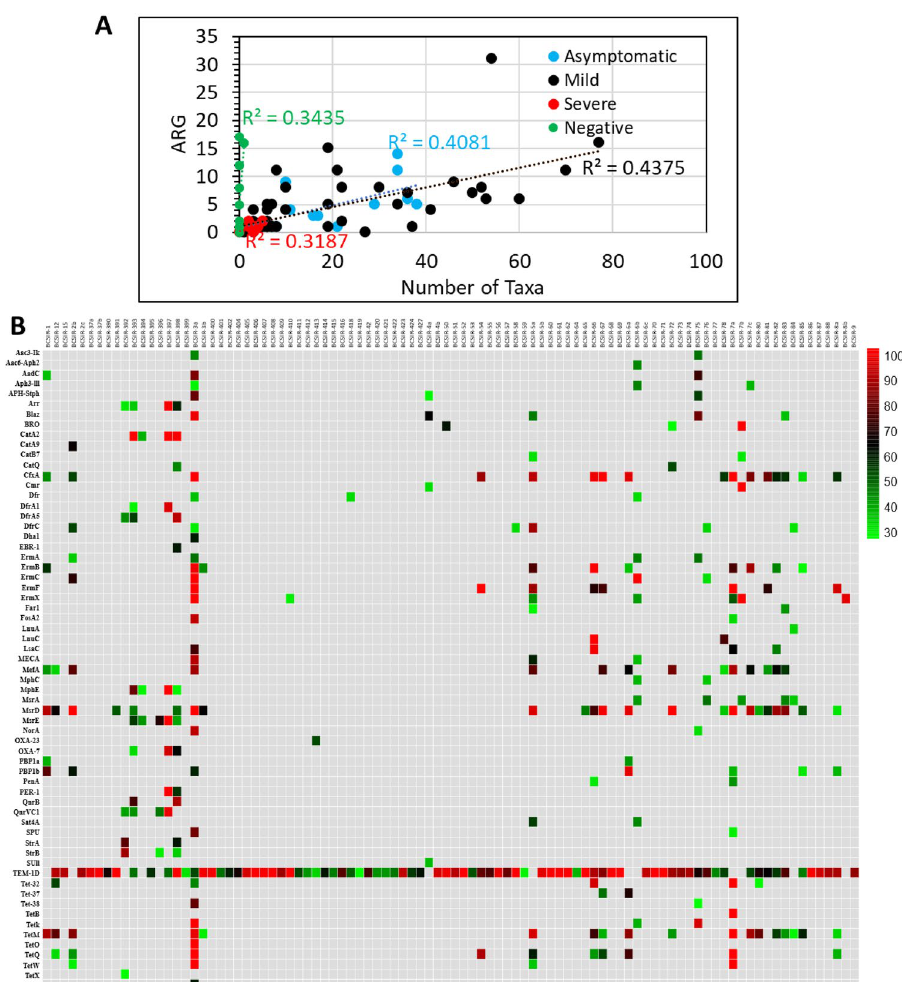
Figure 5. Identification of ARG in COVID-19 cohorts. ( A ) Scatter plot of the number of ARG identified relative to the number of taxa identified by sample. R 2 indicate poor linear correlations. Data was analysed and chart produced in Microsoft Excel version 2212. Green, Negative for SARS-CoV-2; blue, Asymptomatic; black, Mild disease; red, Severe disease. ( B ) Heatmap showing ARG distribution with sequence coverage > 25%. The heat map was based on the NT rPM values and generated using pheatmap version 1.0.12. The colour coding indicating the percentage sequence coverage is shown to the right of the heatmap. The sample identification number is shown at the top and the identified gene product to the